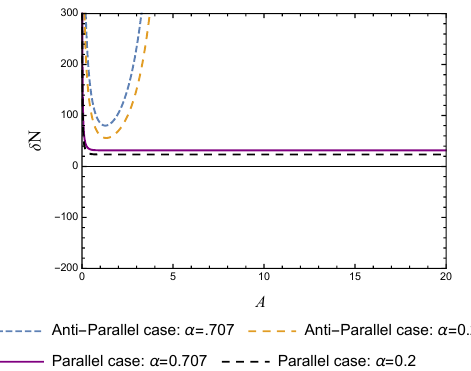
Figure 16 . Parallel and Anti-parallel motions in (1 + 1) dimensions with thermal background: δ N Vs A plot with ∆ E = 1 , the σ = 0 . 2 a B